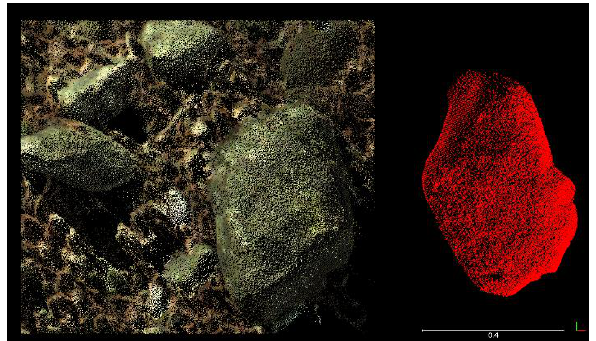
Figure 9 Initial position of point clouds; red – aligned point cloud